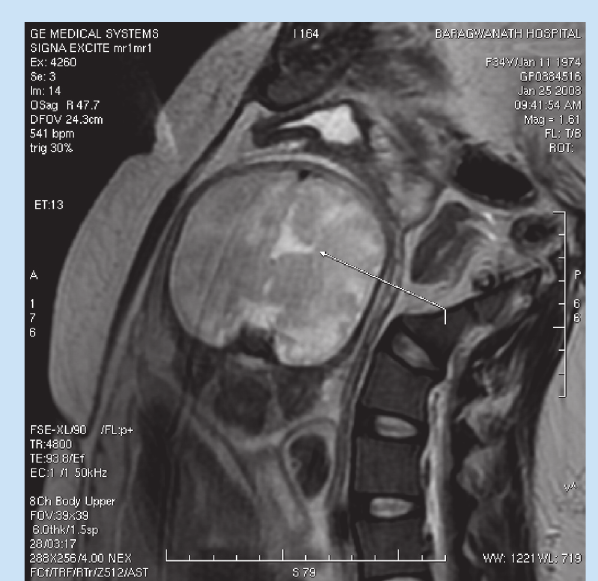
Fig. 3. Coronal T2W image demonstrating tenting of the right lateral ventricle which points to side of the